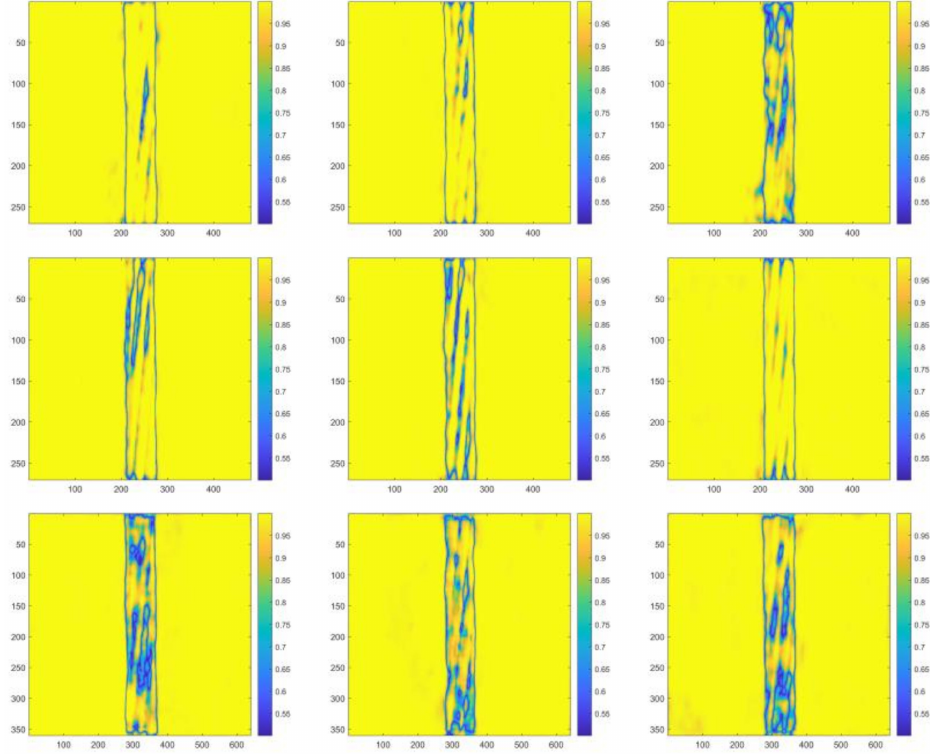
Figure 12. Visualized segmentation results in the heat map form of the same representative testing image with the C-T ratio of 0.12 (left to right, top to bottom, Net-I–Net-IX, respectively, hereinafter).